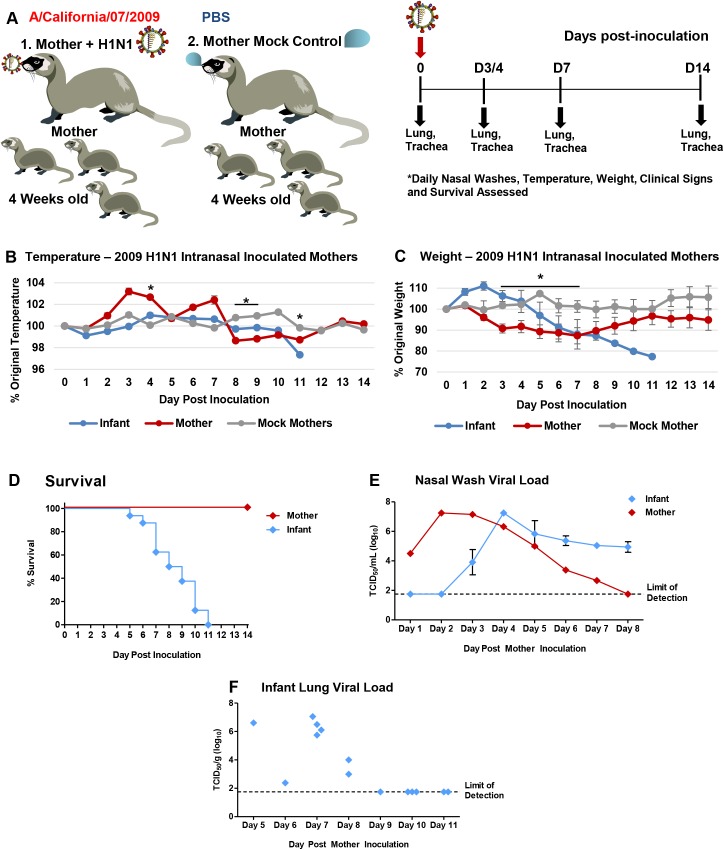
Intranasal 2009 H1N1 infection in mother ferrets leads to severe disease and virus transmission to breastfeeding infants.Schematic of nursing-mothers intranasally inoculated with the Cal/07 strain of 2009 H1N1 influenza (105 EID50) and housed with their feeding infants (A). Temperature (B) and weights (C) were recorded daily for mothers and infants post-inoculation. Grey lines indicate mock inoculated mothers. Survival of mothers and infants post-mother-inoculation (D). Live viral loads were quantified by MDCK titration of nasal wash (NW) (E) and infant lung (F) homogenates collected throughout the infection course (infants that had reached cut-off or succumbed to illness). * indicates a p-value less than 0.05 determined by ANOVA comparing H1N1 inoculated to mock controls. Error bars indicate +/- SD. Data was collected from three independent litter inoculations/infections (3 inoculated/infected mothers, 16 infants, and 3 mock inoculated/infected mothers) and results show the mean or are a representative of the inoculations/infections.